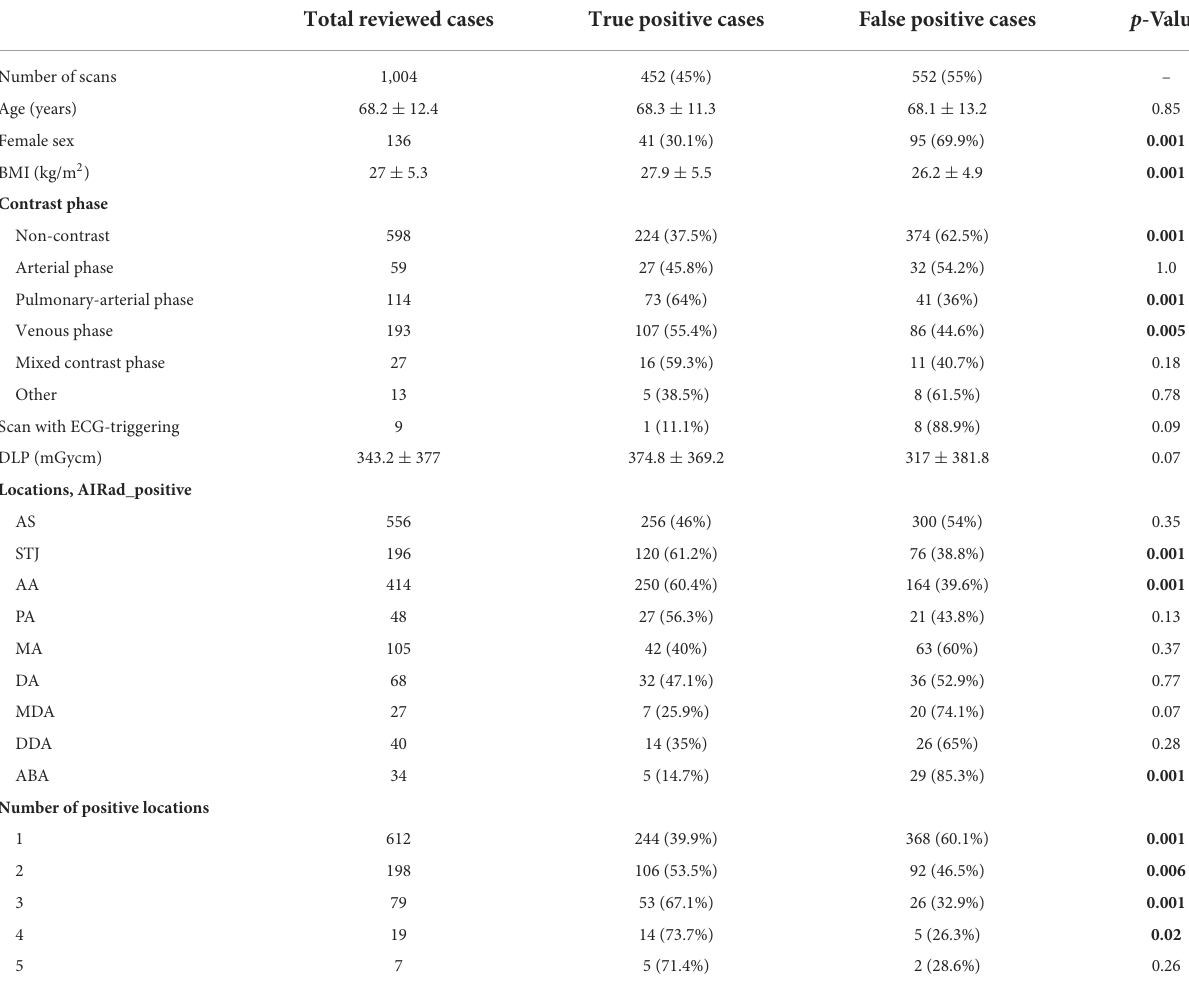
TABLE 2 Reviewed cohort, differences between true positive and false positive